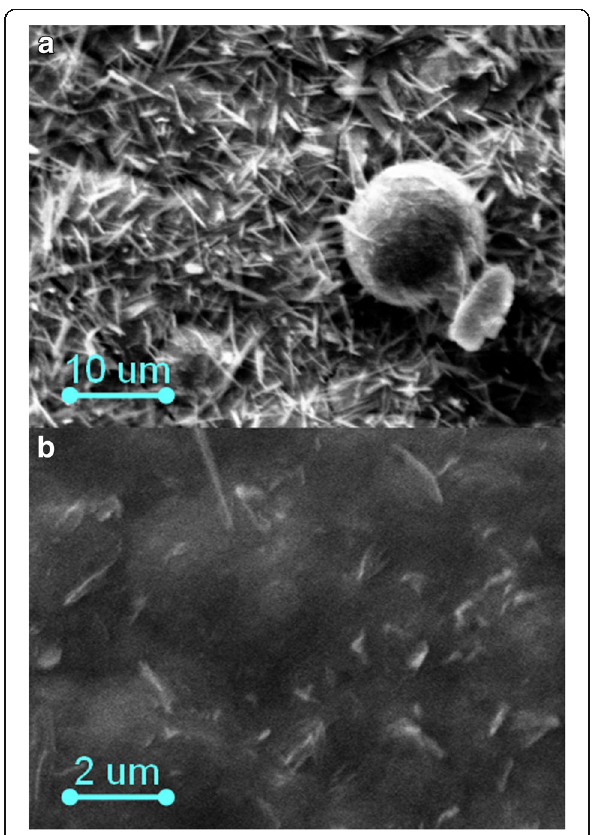
Fig. 3 SEM images of Fe-Co-Mo coatings with thickness of 10 μ m deposited onto copper substrate. a Galvanostatic electrolysis, i = 3 A dm − 2 . b Pulse mode, i = 2 A dm − 2 , t